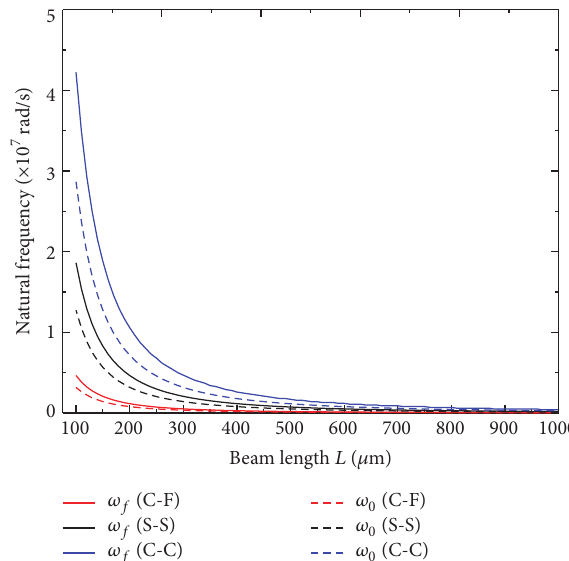
Figure2:Thefirstnaturalfrequencyofthepresentbeammodel( 𝜔 𝑓 ) without voltage and the traditional Euler-Bernoulli beam model ( 𝜔 0 ) versus beam length with different boundary conditions.